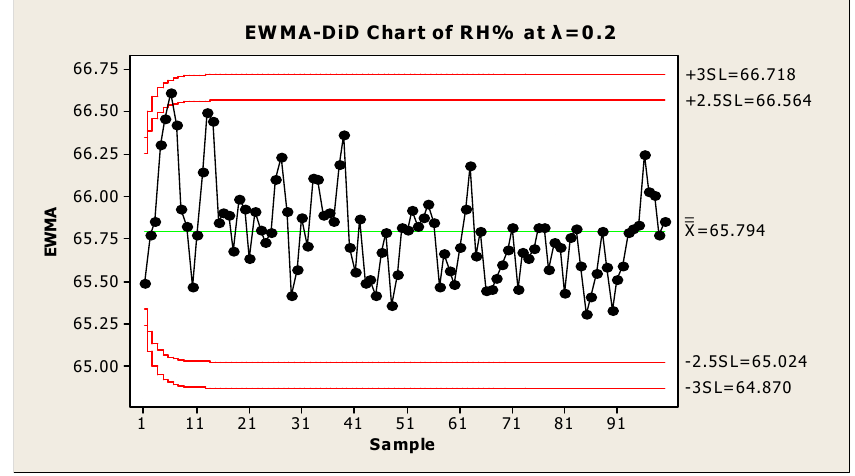
Figure 15. EWMA-DiD Chart of RH% at λ =